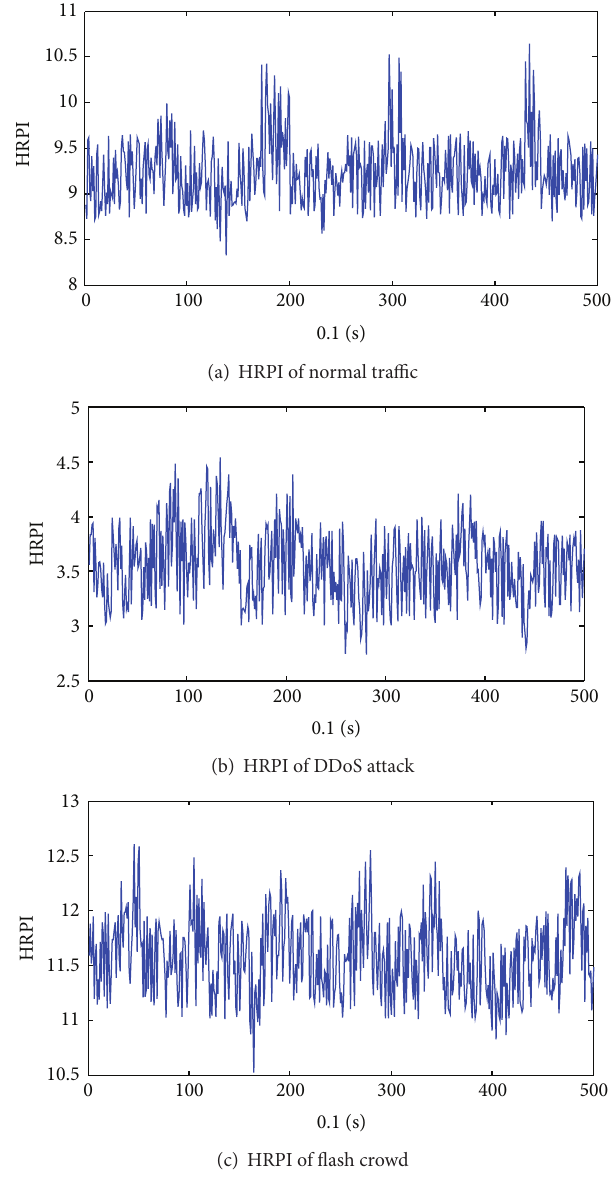
Figure 1: HRPI of different web